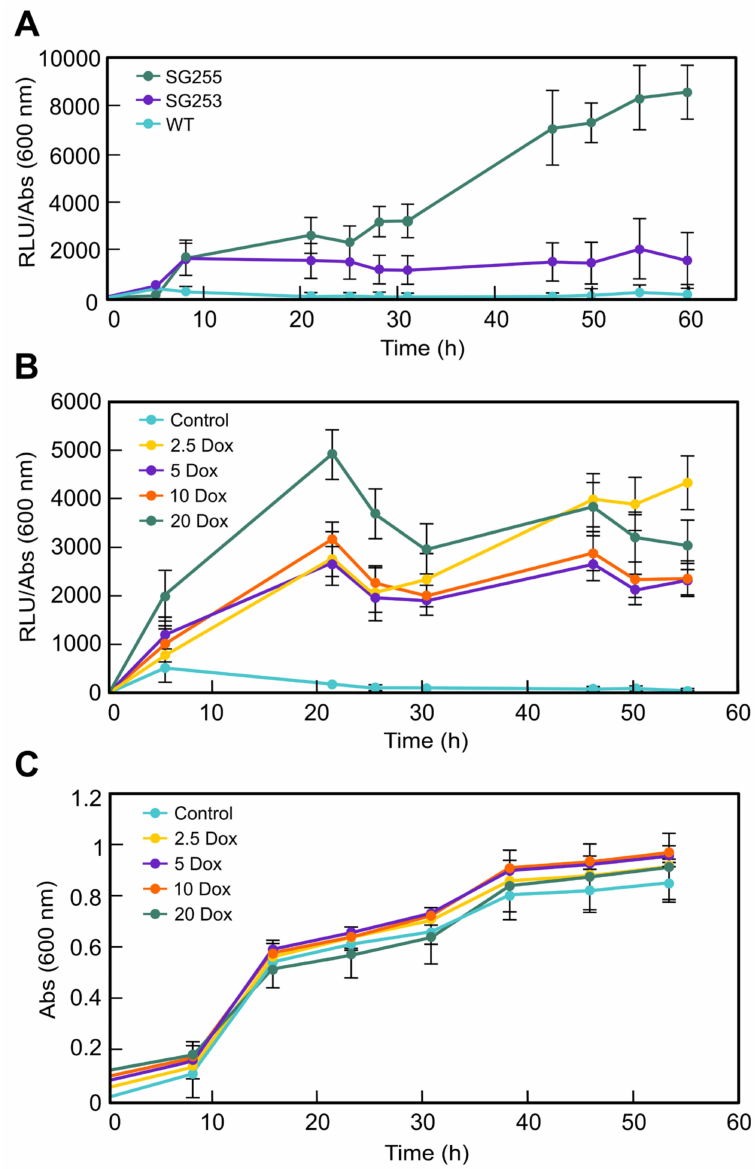
Figure 2. Luminescence emission of TET luc transformants induced with doxycycline (Dox) and compared to the wild strain: ( A ) The TETluc transformants (SG253 and SG255) and the wild strain (WT) were grown in DGpep medium for 16 h in 96-well plates; then, 0.2 mM luciferin and 20 µ g/mL of Dox were added to the wells and incubated in the dark at 30 ◦ C for the time indicated. Data are average and standard deviation for two independent experiments. As a negative control, strains were grown without Dox. ( B ) Luminescence emitted by the TET luc transformant SG255 in DGpep medium in 96-well plates. Dox was added at desired final concentrations (0, 2.5, 5, 10, and 20 µ g/mL) to mycelia previously grown for 18 h. ( C ) Growth of SG255 in the 96-well plates described in panel B, measured by their absorbance at 600 nm. Data are average and standard deviations for three independent